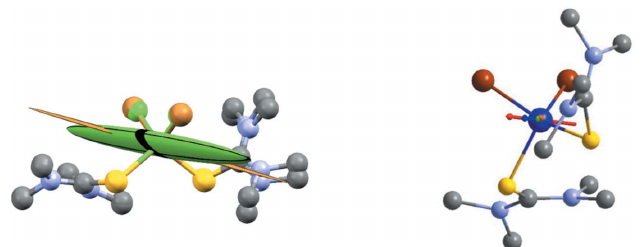
Figure 4 ( a ) Atomic susceptibility tensors for Co derived from PND for 1 and 2 , illustrated as thermal ellipsoids. The eigenvalues of the susceptibility tensors are (cid:2) 0.29 (1), 0.86 (1), 4.07 (1) (cid:3) B / T for 1 and 0.03, 0.11, 2.38 m B / T for 2 . The negative eigenvalue is shown as positive and the ellipsoids have been scaled arbitrarily for the purpose of visualization. The ellipsoids for Co are colored green and brown in 1 and 2 , respectively. ( b ) Magnetic easy axes from theory and experiment on 1 and 2 . The easy axes directions are shown as red, green, blue and orange arrows for Cl- experimental, Br-experimental, Cl-theoretical and Br-theoretical, respec- tively. All arrows are overlaid on the molecular structure of 2 using the same procedure of RMSD-minimization as described in the main text. Atoms are colored purple (Co), yellow (S), gray (C), blue (N), brown (Br), green